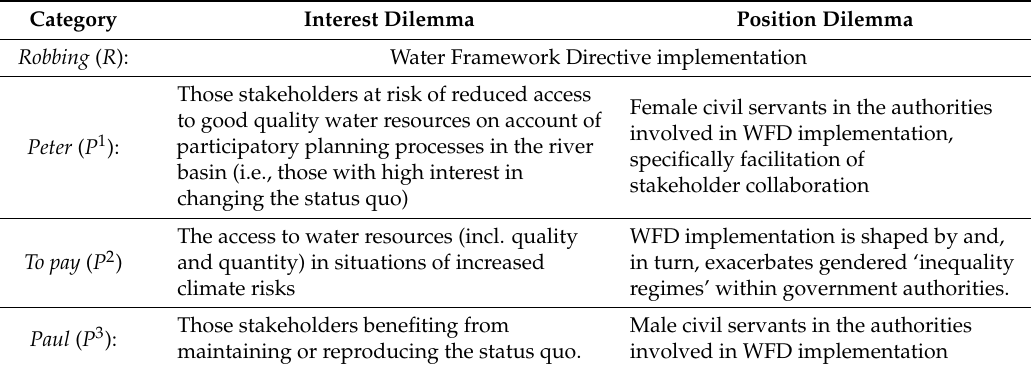
Table 2. Application of the RP3 idiom to the Water Framework Directive